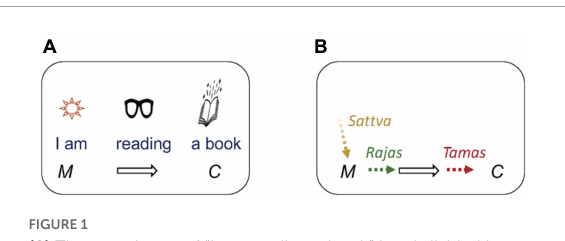
FIGURE1 (A) The experience of “I am reading a book” is subdivided into the mental object (“book”) or citta (depicted by C), the mental action performed on that object (“reading”) or ahamtattva (depicted by the black arrow), an existential component of consciousness (“I am”) or mahattattva (depicted by by M). Finally, the component “I am” is proposed to further comprise an experiencer (“I”) and a bare experience (“am”) devoid of the mental act and mental object. “I” is proposed as the unqualified background field or essence consciousness upon which all experience takes place depicted by the background encompassed by the rounded rectangle. (B) The three gunas, prakriti, purusha, samkhya gunas of Prakriti according to Samkhya philosophy qualify the background essence consciousness (equated to Purusha or witnessing consciousness in Samkhya). Purusha (background) qualified by sattva ( guna ) begets mahattattva (M). Mahattattva qualified by rajas begets ahamtattva (black arrow). Ahamtattva qualified by tamas begets citta